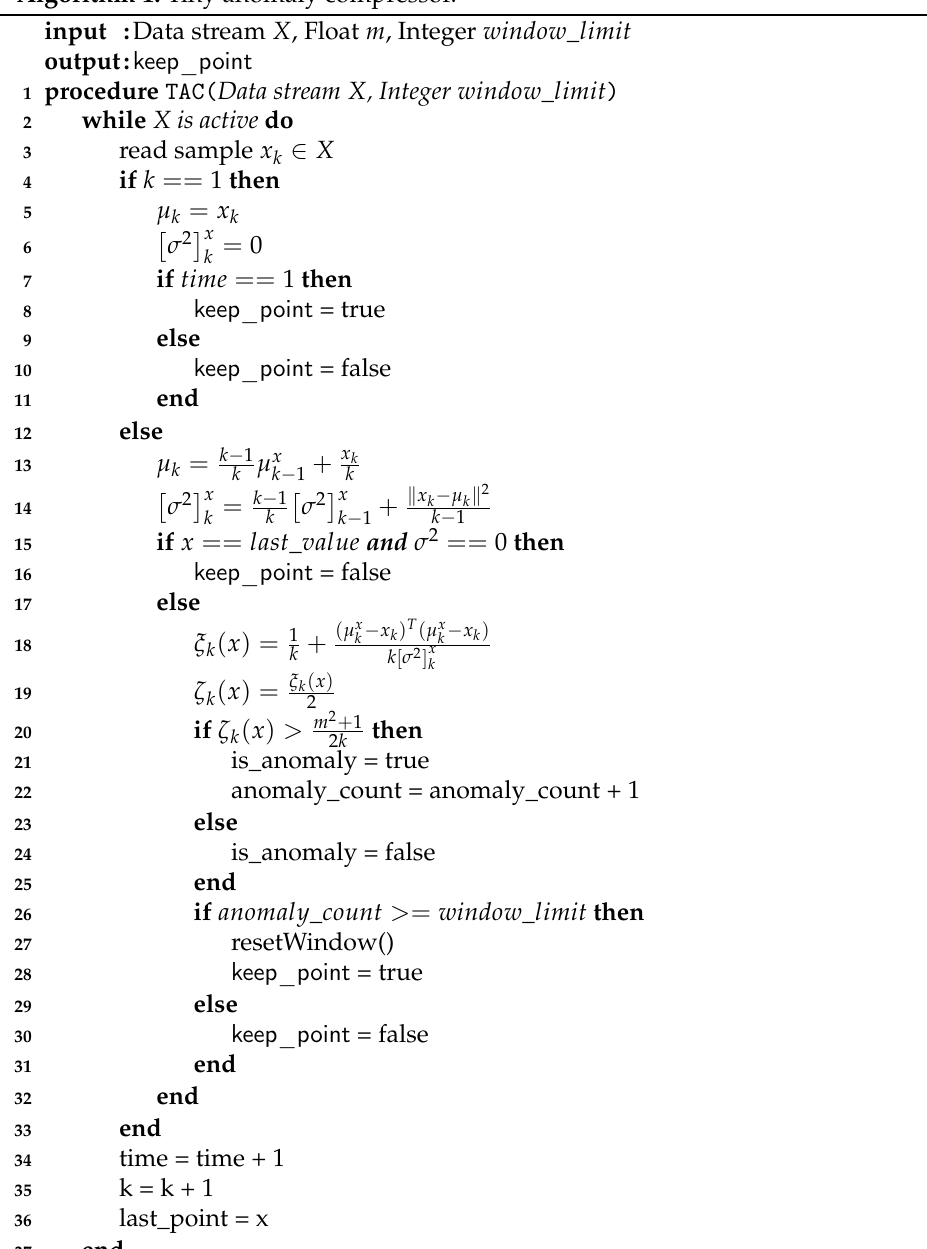
Algorithm 1: Tiny anomaly